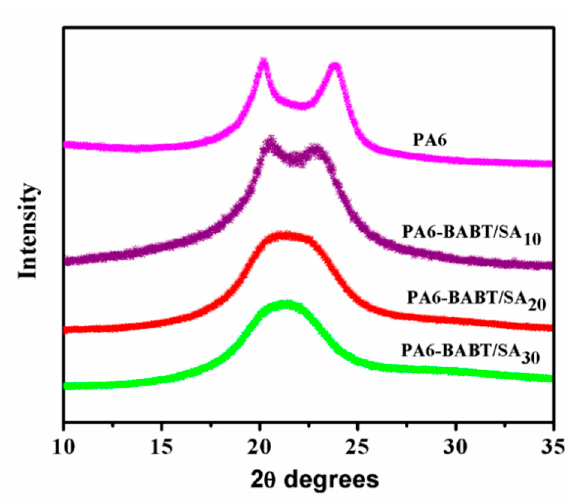
Figure 13. X-ray diffraction (SRD) of PA6 and PA6-BABT/SA copolyamides with different weight contents of BABT/SA salt.